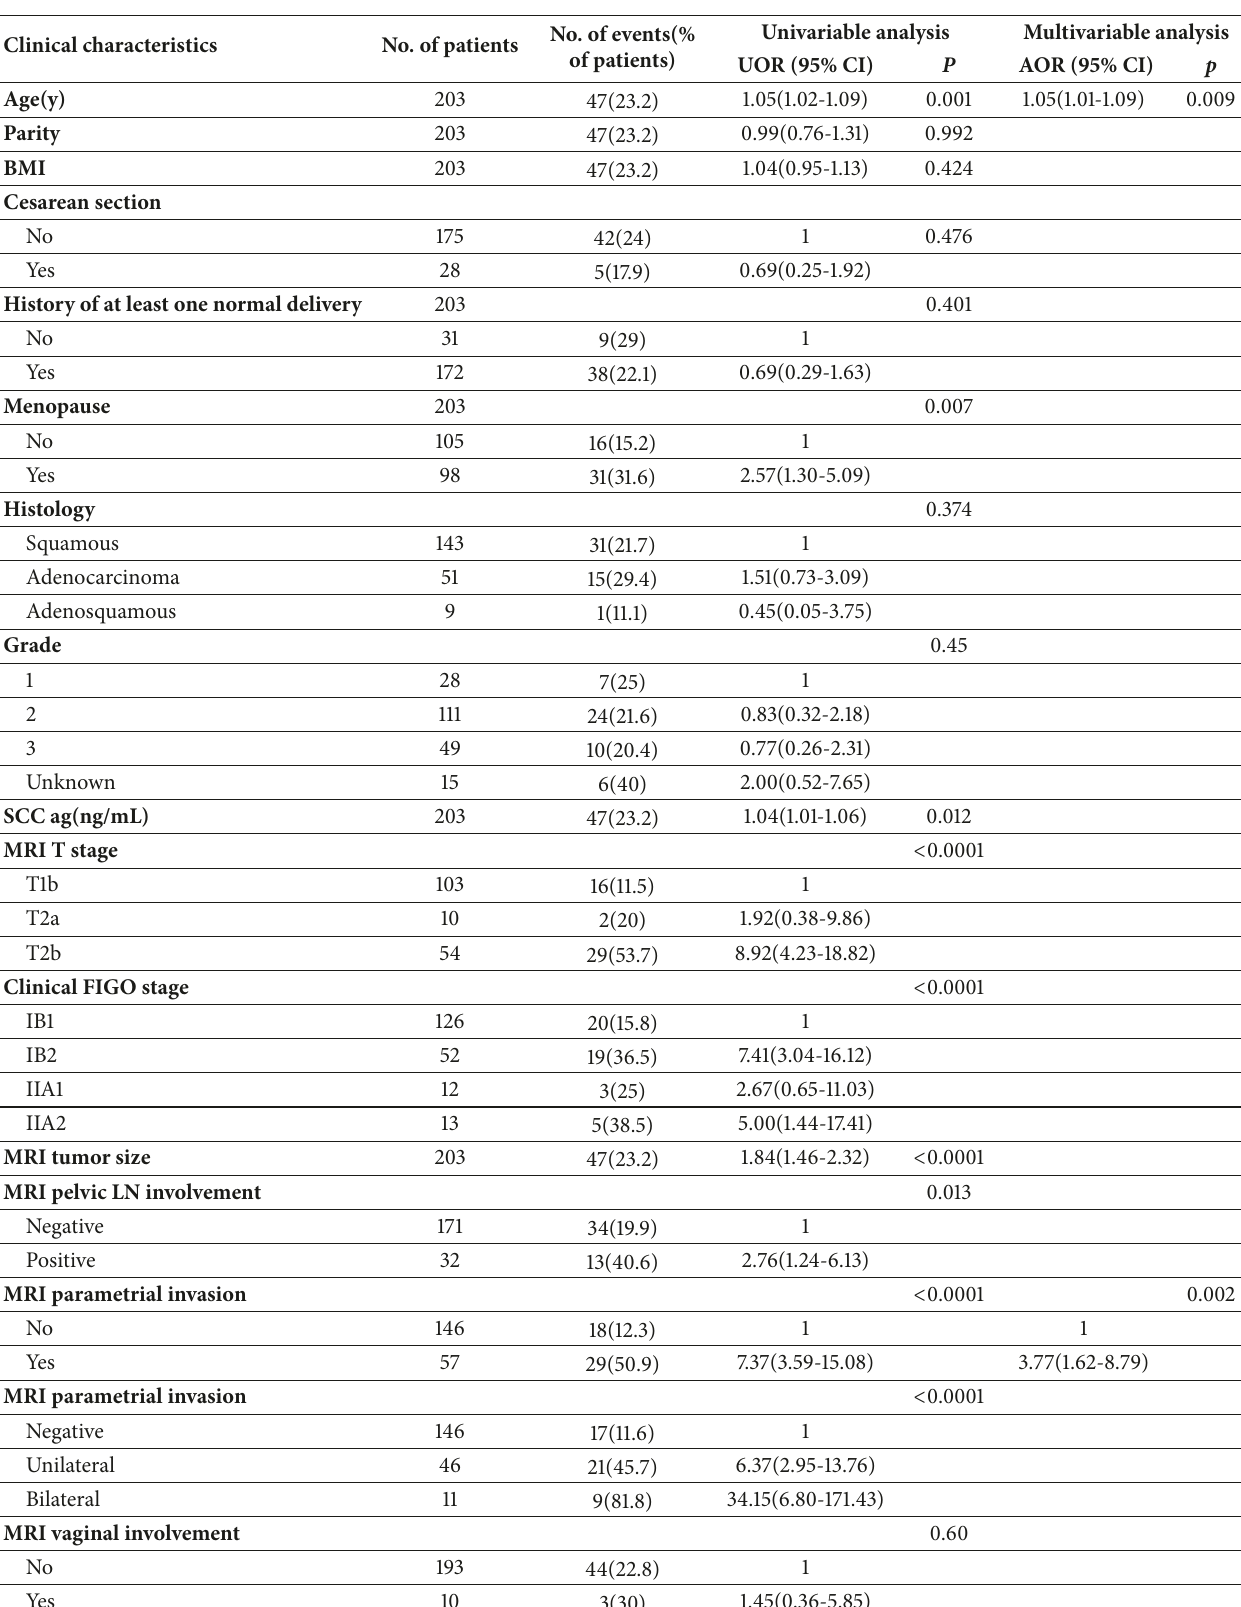
Table 2: Adjusted odds ratios with 95% confidence intervals (CI) and associated P values from the logistic regression predicting pathologic category T2b in the 203 study cohort